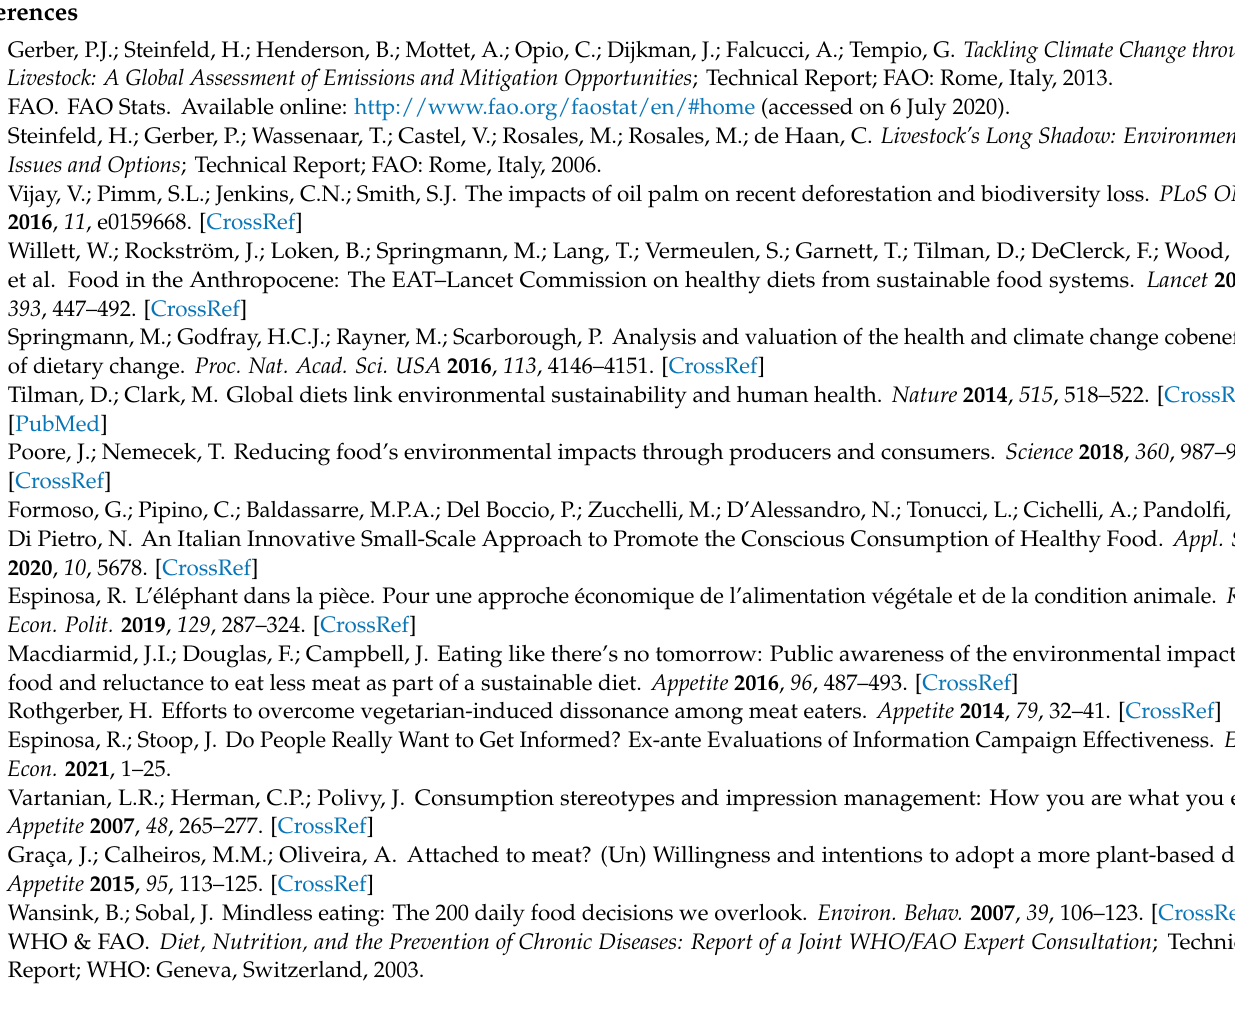
Figure A3. Conditional effect of awareness on policy acceptability in an interaction effect model— confirmatory analysis. Note: Results of a linear regression of acceptability with policy fixed effects, topic fixed effects, individual random effects, all identified acceptability factors, demographics, and an interaction term between awareness and